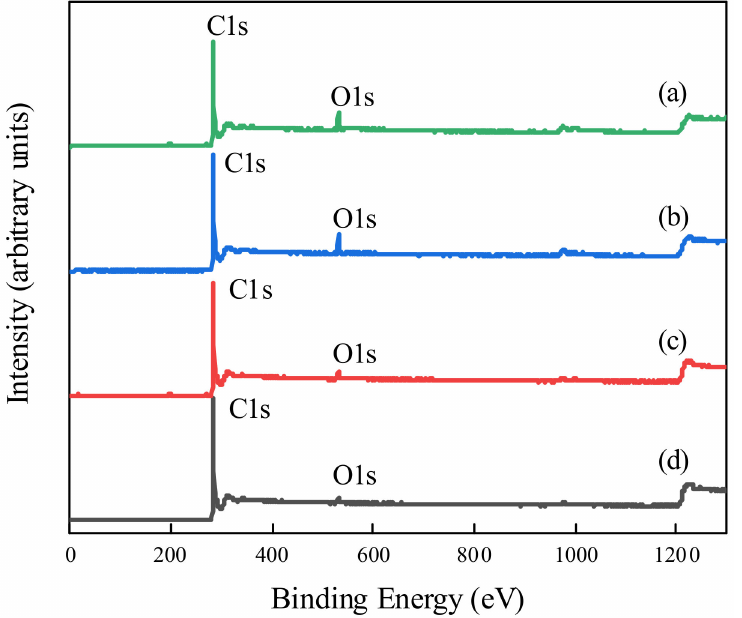
Figure 5. The XPS diagram of PEG non-covalent-functionalized MWCNT membranes: ( a ) PEG–